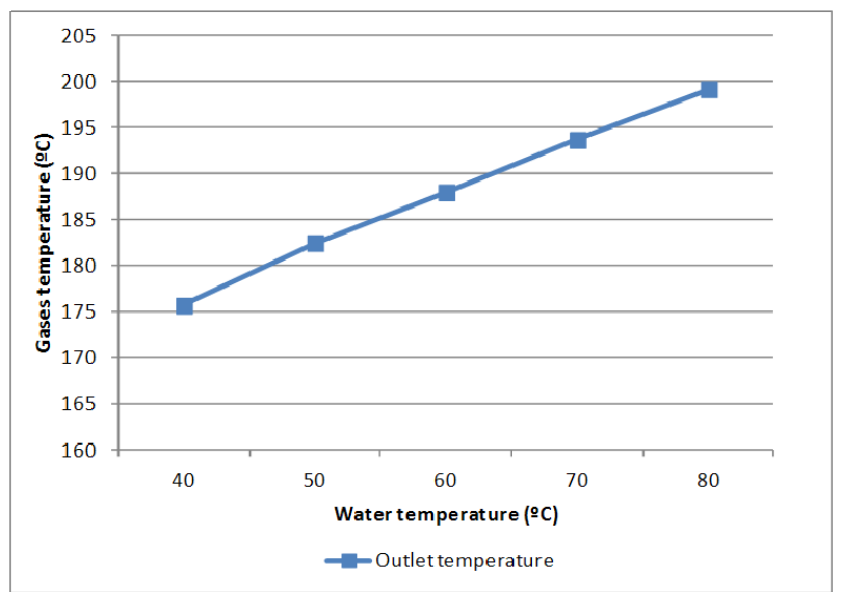
Figure 7. Temperature of the flue gases